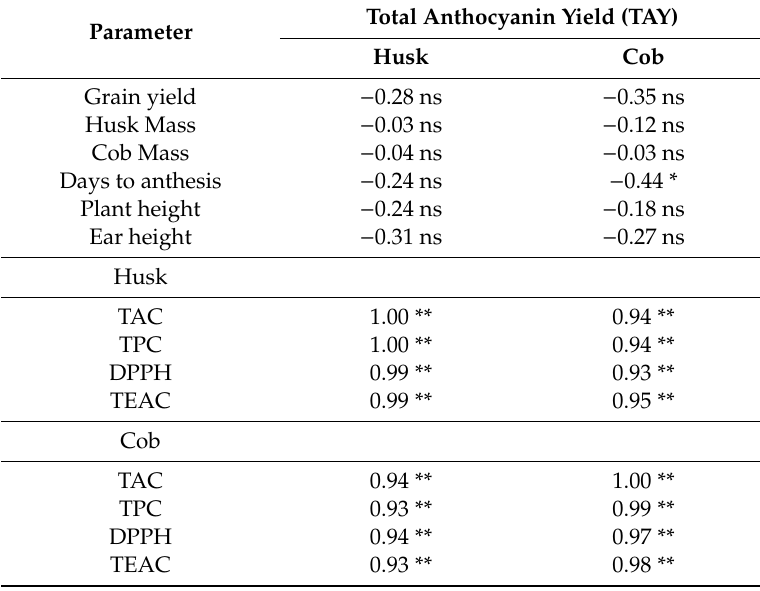
Table 7. Pearson correlation coe ffi cients between grain yield, agronomic traits, total anthocyanin content (TAC), total phenolic content (TPC) and antioxidant activity determined by the DPPH and the TEAC methods and total anthocyanin yield (TAY). Total Anthocyanin Yield (TAY) Parameter Husk Cob Grain yield − 0.28 ns − 0.35